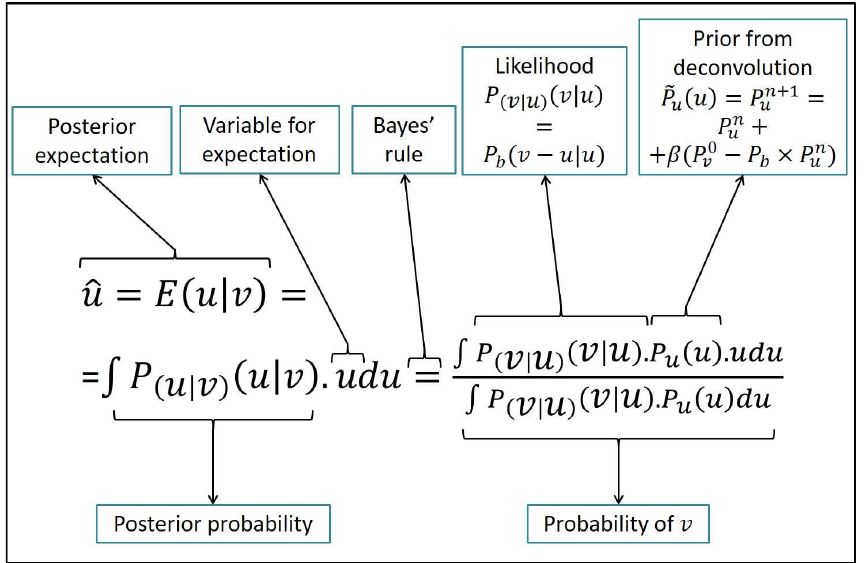
Figure 2. Overview of the non-parametric Bayesian formulation for image restoration. The restoration is repeated